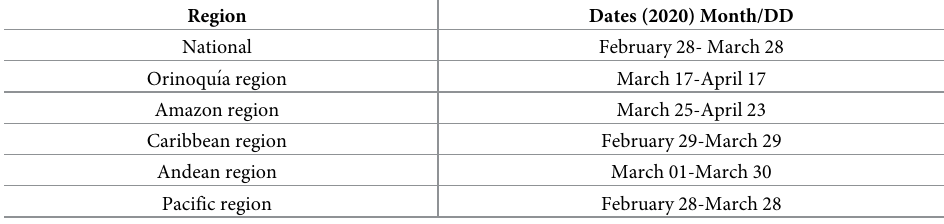
Table 1. Dates for R